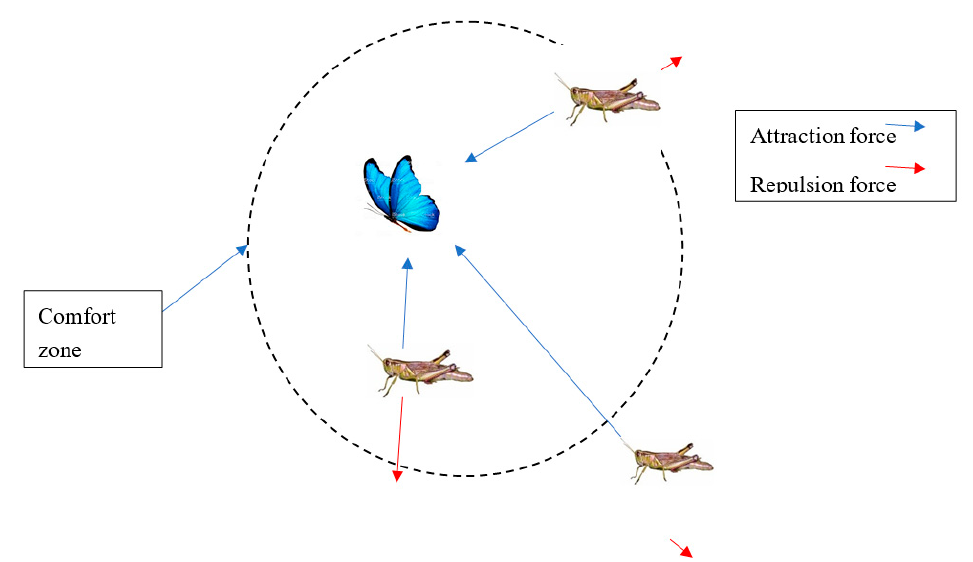
Figure 6. The embryonic reformist styles between each grasshopper in the herd.